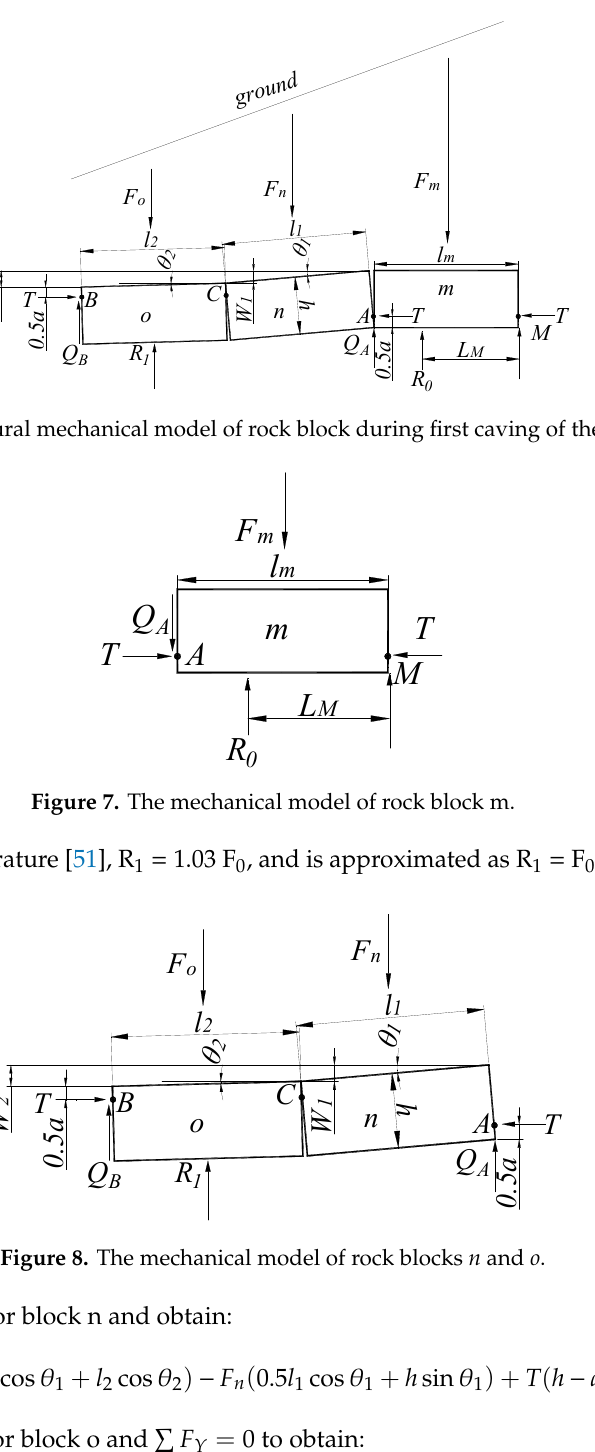
Figure 5. Schematic of step rock beam.